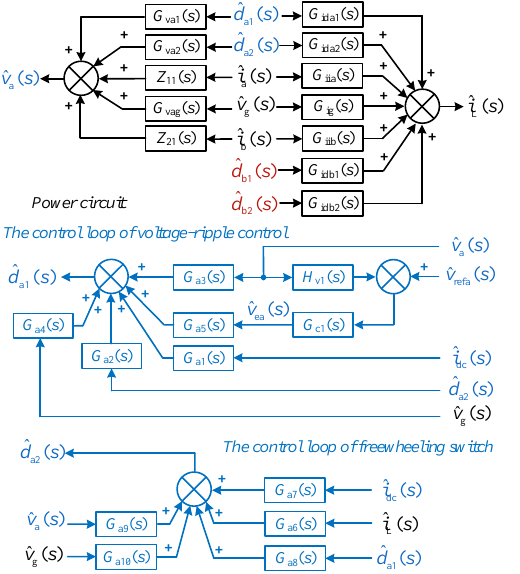
Figure 6. Small-signal model of voltage ripple-controlled PCCM SIDO buck converter. Table 1. Parameters of voltage ripple-controlled PCCM SIDO buck converter.